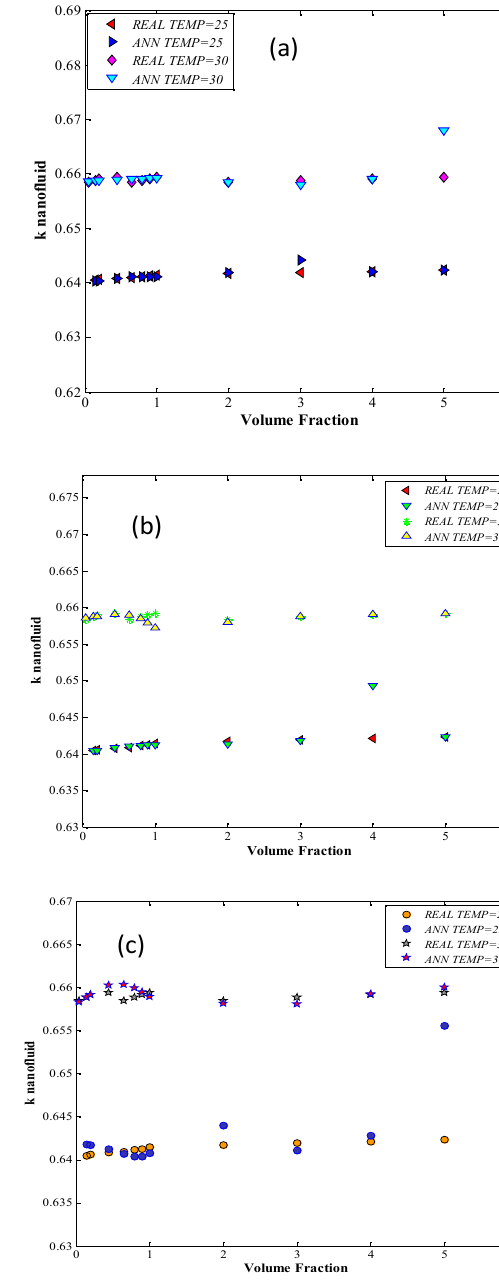
Fig. 7: a, b, and c: The comparison between experimental results and predicted results obtained by neural network for thermal conductivity with 10, 15 and 20 neurons, respectively ( x : the number of samples, y: the maximum and minimum error values for the tested samples) Fig. 8: a, b, and c: The comparison between experimental results and predicted results obtained by neural network for thermal conductivity with 10, 15 and 20 neurons, respectively (x : volume fraction of Fe 3 O 4 nanoparticles, y: thermal conductivity ratio of the nanofluid)